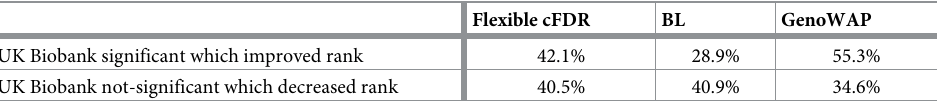
Table 3. Summary of locus-level results when leveraging GenoCanyon scores with asthma GWAS p -values. Table lists the percentage of the 114 FDR significant index SNPs in UK Biobank which improved rank (“UK Biobank significant which improved rank”) and the percentage of the 301 index SNPs that were not FDR significant in UK Bio- bank which decreased rank (“UK Biobank not-significant which decreased rank”) after applying Flexible cFDR, BL or